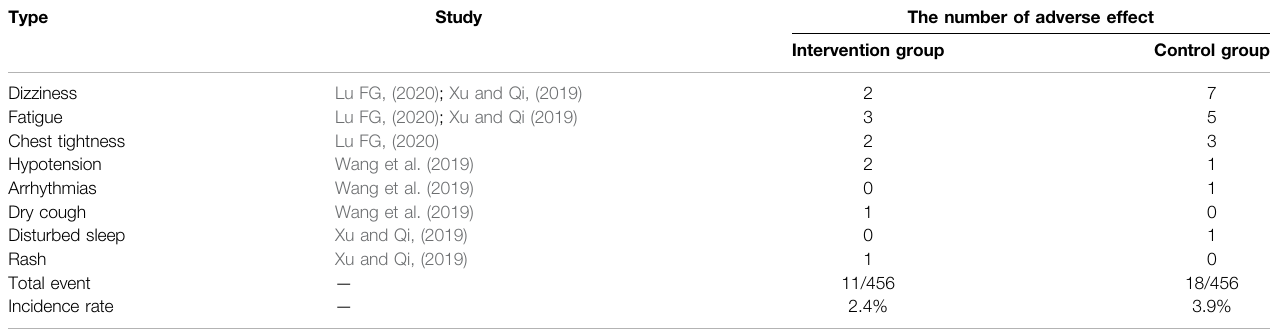
TABLE 3 | The incidence rate of adverse